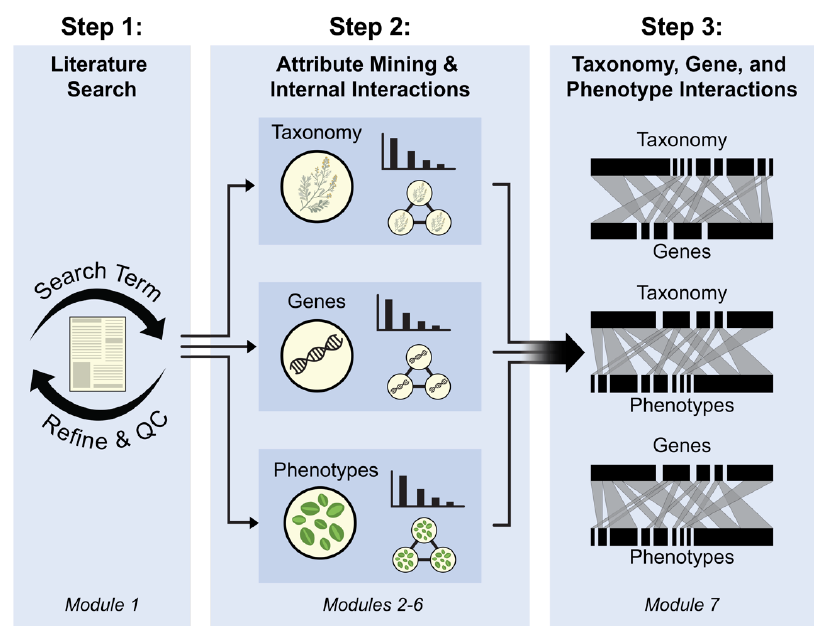
Figure 1: A flowchart showing the progression of a G2PmineR analysis. Abbreviation: QC = Quality Check. See text for more details.